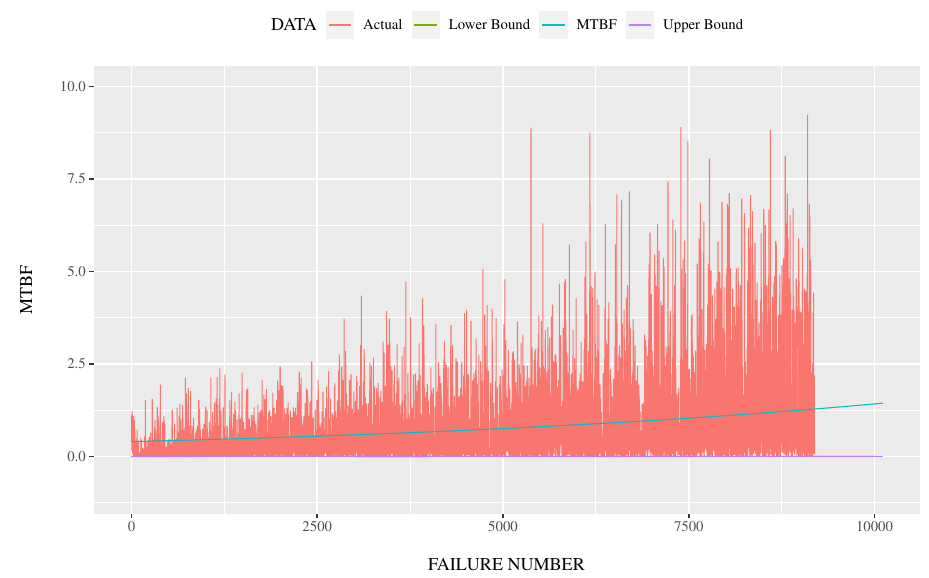
Figure 9. The estimated upper and lower confidence limits based on the conventional method in the case of the Moranda